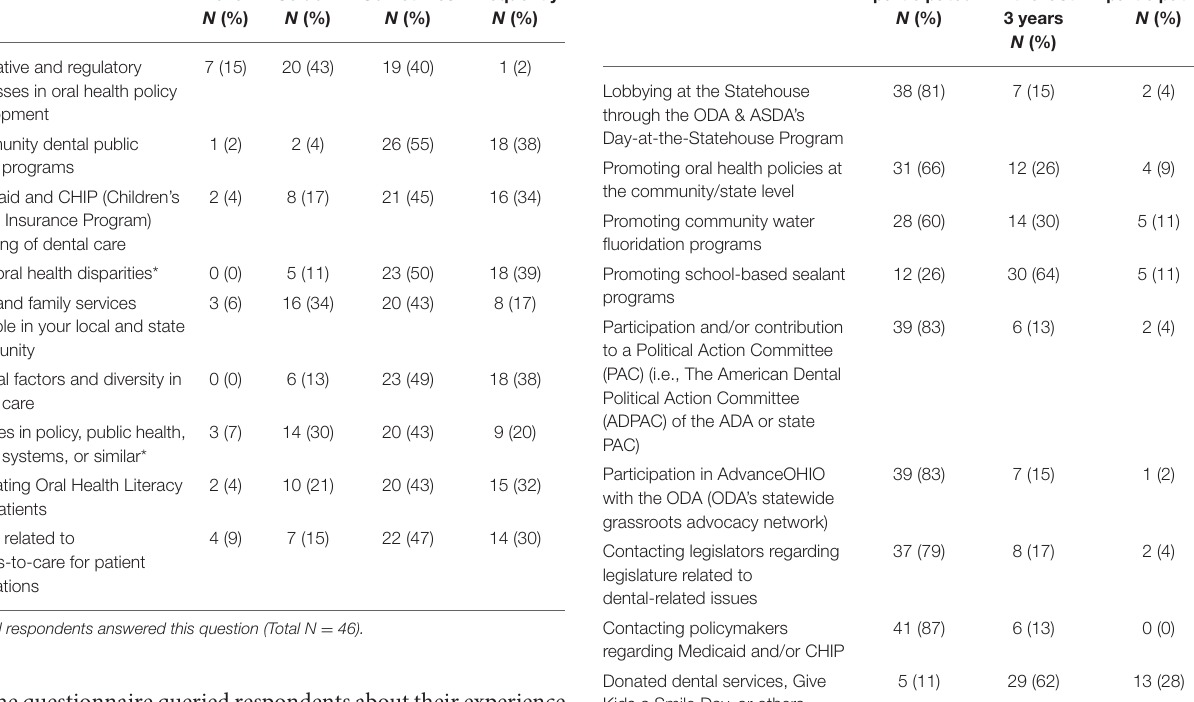
TABLE 2 | Frequency of Exposure to Various Topics as part of DDS Didactic Curriculum (Total N = 47). Item Never Seldom N (%) N (%)